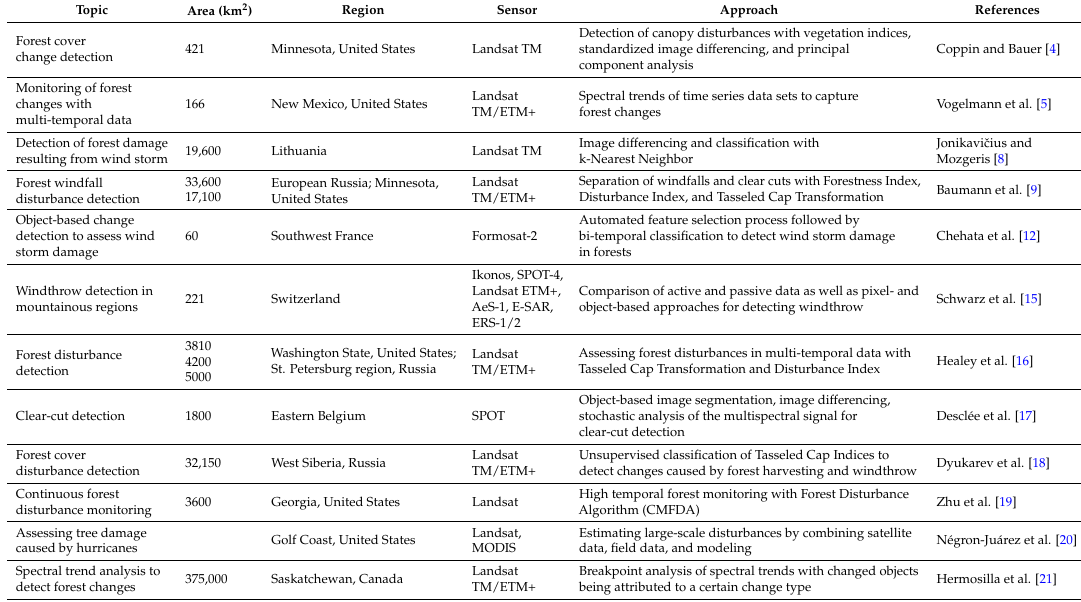
Table 1. Selection of essential previous studies for forest disturbance detection. Most studies used medium resolution (deca-metric) satellite data and pixel-based approaches on temperate and boreal forest ecosystems. Abbreviations: TM (Thematic Mapper), ETM+ (Enhanced Thematic Mapper Plus), SPOT (Satellite Pour l’Observation de la Terre), AeS (Aero-Sensing), E-SAR (Experimental airborne SAR), ERS (European Remote Sensing